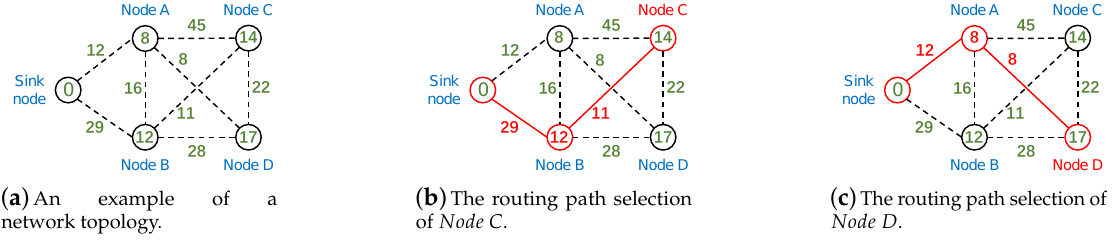
Figure 4. ( a ) the numbers in circles represent the node delays and the numbers on dash lines are link delays; ( b ) the routing path for Node C is: Node C -> Node B -> Sink node , and the overall delay is 52 cycles; ( c ) the routing path for Node D is: Node D -> Node A -> Sink node , and the overall delay is